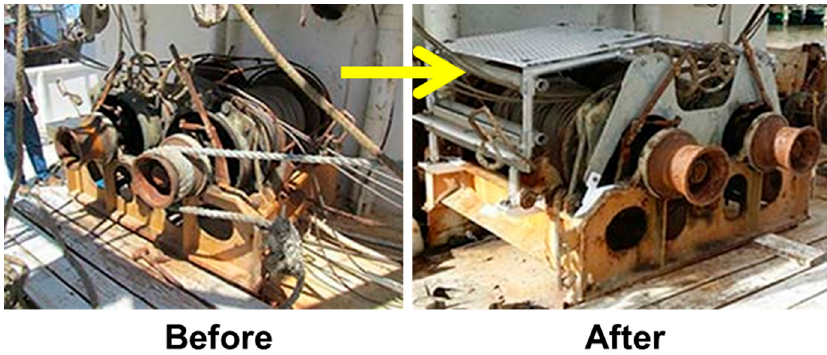
Figure 3. An example of a winch in a Gulf of Mexico vessel before and after a guard is attached. Source: NIOSH 2015 [12].